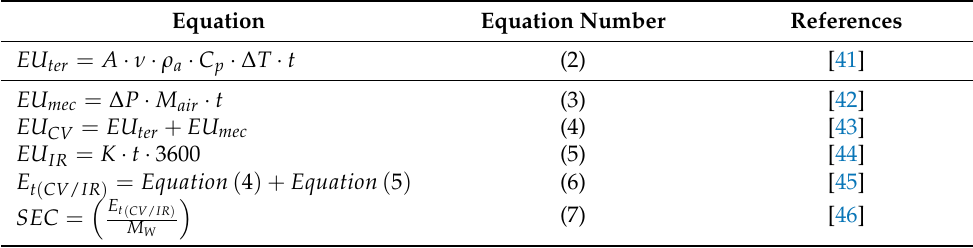
Table 1. Formulas used for determining the energy consumption of